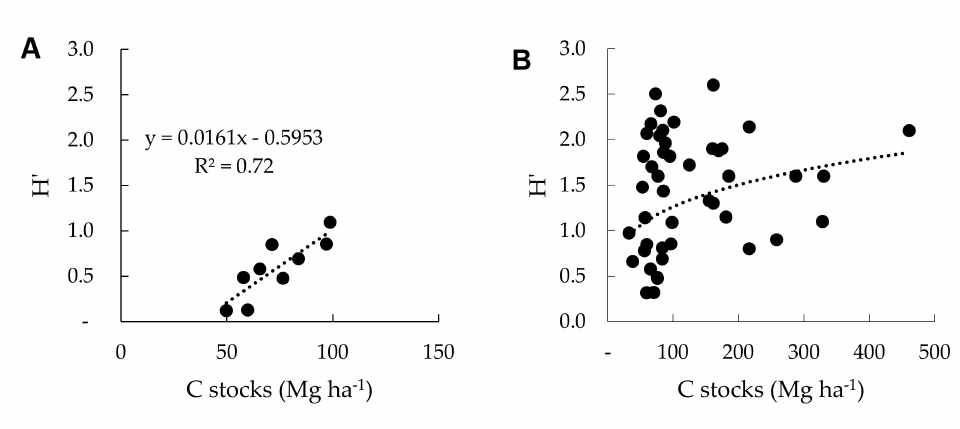
Figure 4. ( A ) The relation between total C stock and tree diversity (H index) in the cacao-based agroforestry systems in this study; ( B ) In agroforestry systems across Indonesia (primary data plus [15,49,52–54]).